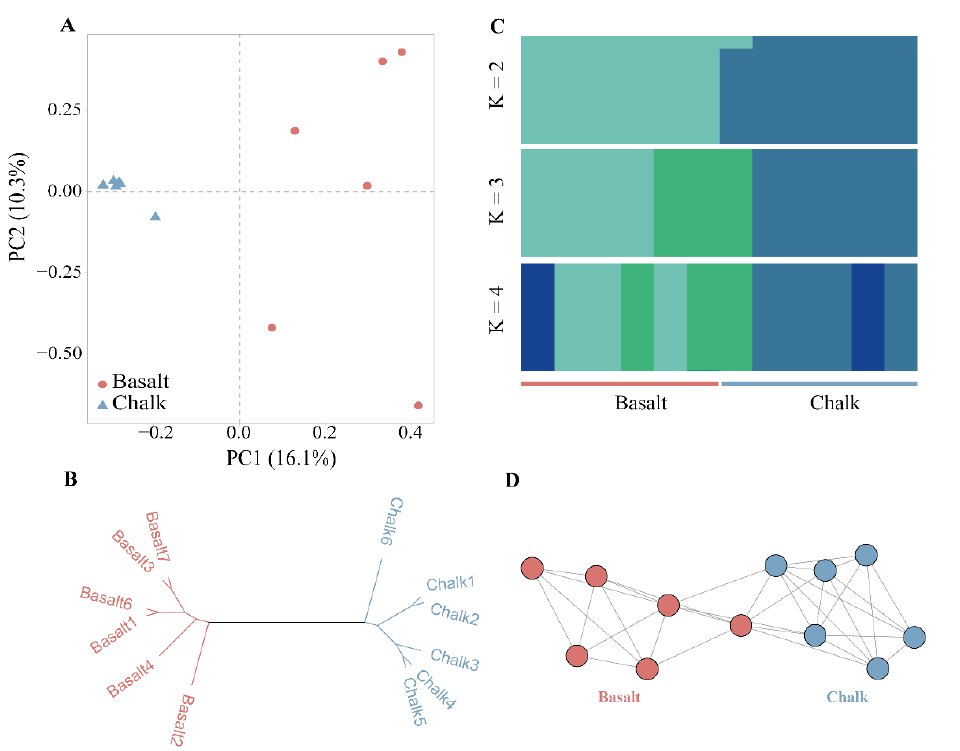
Figure 5. Sympatric divergence of the single bacteria of Streptomyces lividans . ( A ) Principal component analysis shows samples from basalt clustered together, and samples from chalk were in one cluster. ( B ) Phylogenetic tree of the chalk and abutting basalt populations. ( C ) Population structure analysis. ( D ) Genetic network analysis.